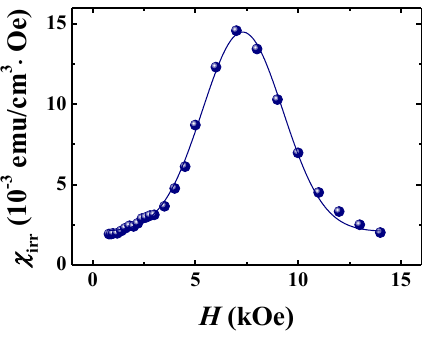
Fig. 7. Field dependence of irreversible magnetic susceptibility χ irr at T = 300 K. Solid line is a guide for the